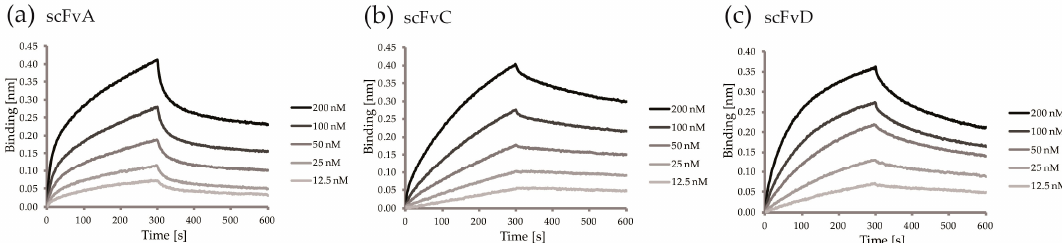
Figure 5. Binding profiles of the selected scFv fragments to FGF1. ( a – c ) Serial twofold dilutions of the scFvs were analyzed for interaction with chemically immobilized FGF1, and dissociation measured in kinetics buffer (KB). Table 1. Kinetic constants of the generated anti-FGF1 scFvs.